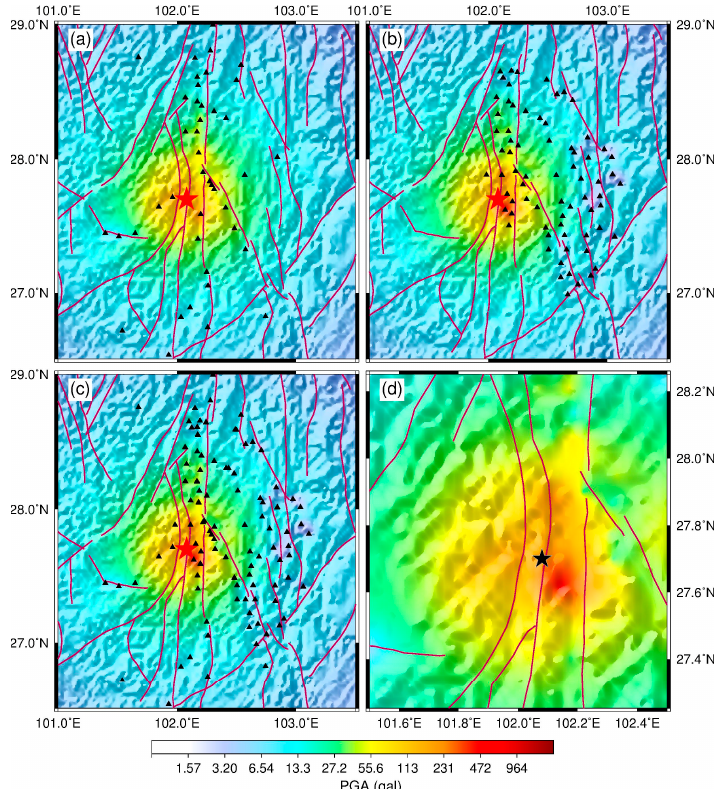
Figure 6. Peak ground acceleration (PGA) shake maps for the 31 October 2018, M 5.1 Xichang earthquake produced by ( a ) traditional trigger-mode strong-motion stations, ( b ) the GL-P2B sensor network, and ( c ) the combined networks (traditional trigger-mode strong-motion and GL-P2B stations). ( d ) PGA shake map for the earthquake source regions of the Xichang earthquake produced by the combined networks. The triangles represent the distribution of traditional and GL-P2B stations, while the star indicates the epicenter of this earthquake. The 16 May 2018, M 4.3 Shimian earthquake was selected as an example to check whether we could directly use the GL-P2B sensor network without virtual stations to generate a PGA shake map for an earthquake. The source region of this event was well surrounded by the low-cost seismic network. As shown in Figure 7, one can find that the result without using virtual stations is more reasonable because the values derived from the GMPE usually contain system biases. Therefore, a dense array deployed with low-cost MEMS sensors is very useful for this purpose.